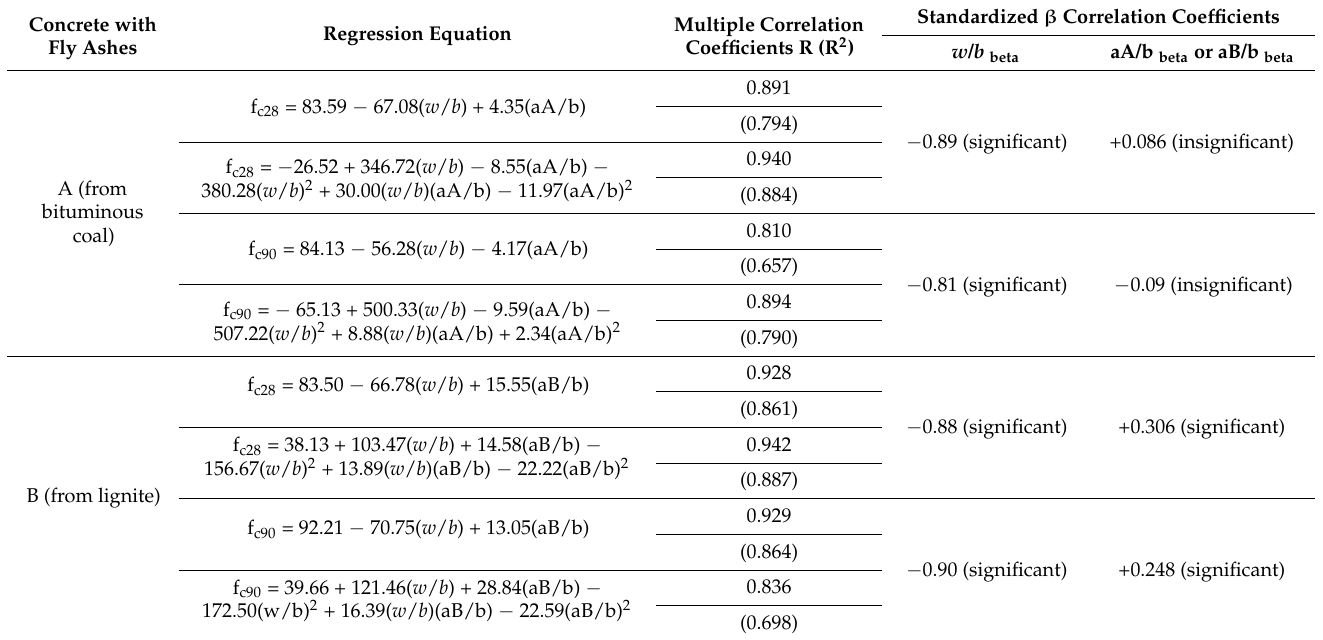
Table 9. Regression equations describing the f c28 or f c90 = f ( w / b ; aA/b or aB/b) relationships and their characteristics. Concrete with Fly